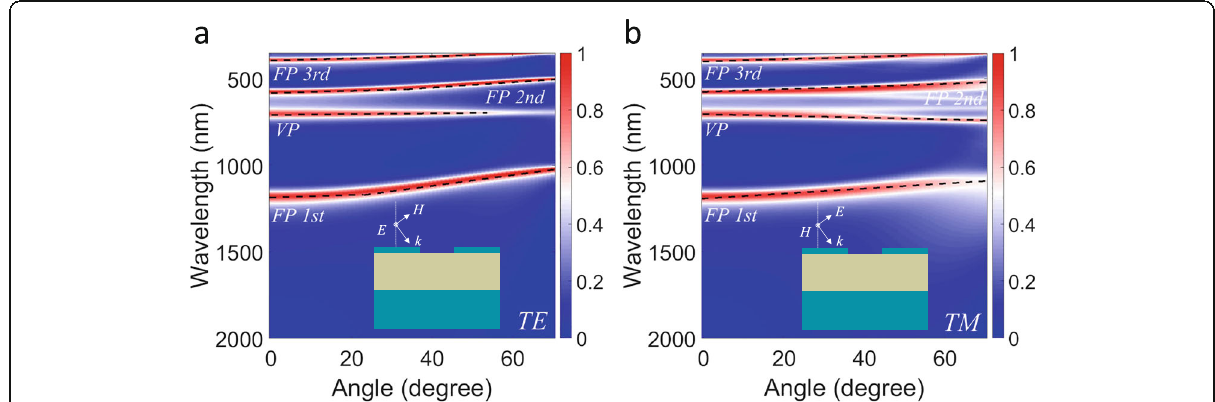
Fig. 3 Calculated absorption contours of the proposed nanohole array-based absorber as a function of wavelength and incident angle: a TE and b TM polarization. Here, the structural parameters of the absorber are set as p = 200 nm, w = 60 nm, h 1 = 20 nm, h 2 = 250 nm, and h 3 = 200